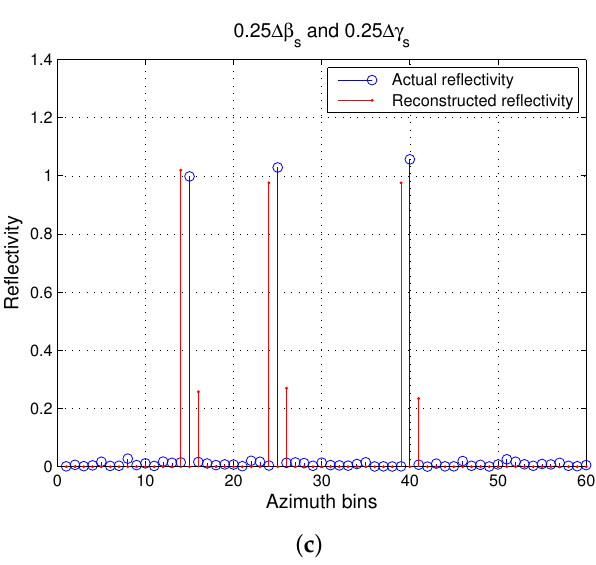
Figure 7. ( a ) Mismatch of 0.05 ∆ β s and 0.05 ∆ γ s ; ( b ) mismatch of 0.05 ∆ β s and 0.1 ∆ γ s ; ( c ) mismatch of 0.25 ∆ β s and 0.25 ∆ γ s . As the cumulative β mismatch and γ mismatch increases, higher sidelobes